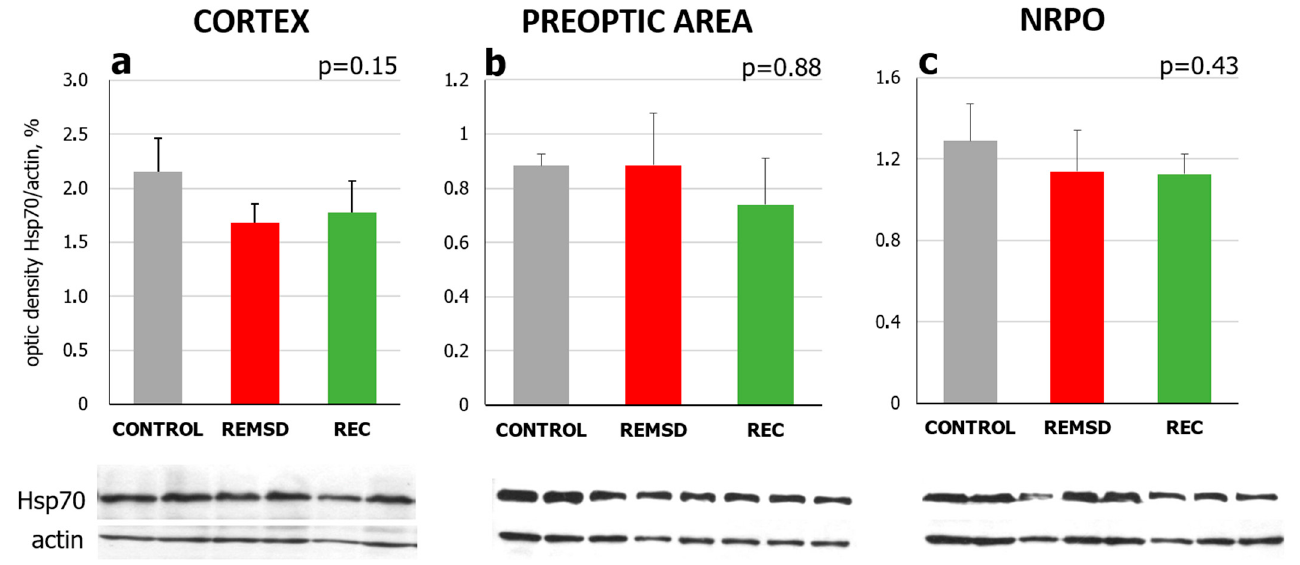
Figure 7. Hsp70 protein levels in ( a ) the sensorimotor cortex, ( b ) the preoptic area of the hypothalamus and ( c ) the nucleus reticularis pontis oralis (NRPO) after 6 h selective REM sleep deprivation (REMSD) and during the highest REM sleep rebound in the recovery period (REC). CONTROL, grey—undisturbed animals, ZT06. REMSD, red—rats were sacrificed after REMSD, ZT06; REC, green—rats were sacrificed after an episode of REMS 2 h into the recovery period, ZT08. Values are shown as mean ± s.e.m, n = 3 for each group. p values were calculated using the Kruskal–Wallis H test. Representative immunoblots are shown under the respective graphs.